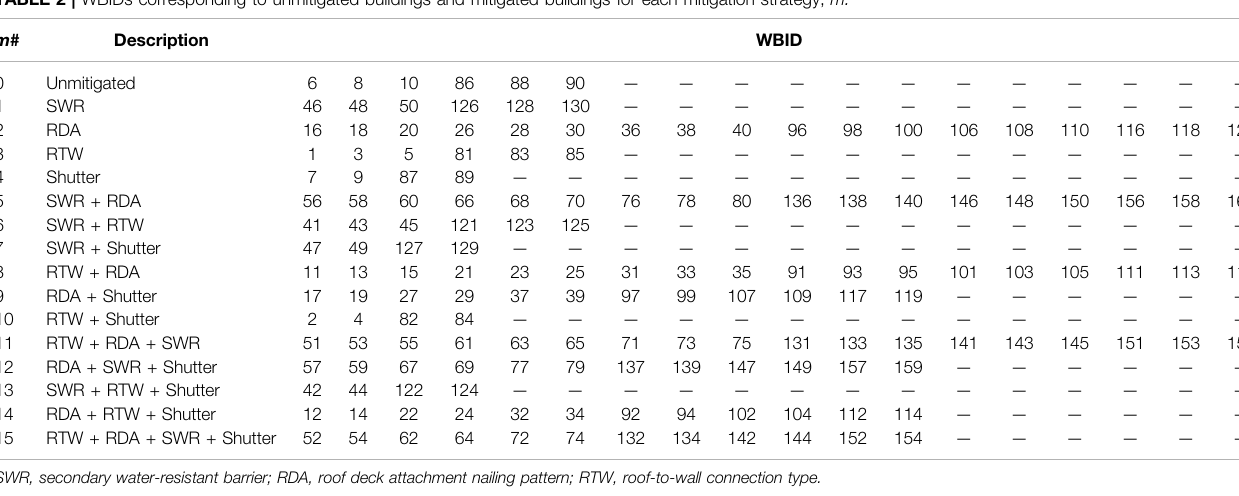
TABLE 2 | WBIDs corresponding to unmitigated buildings and mitigated buildings for each mitigation strategy, m.